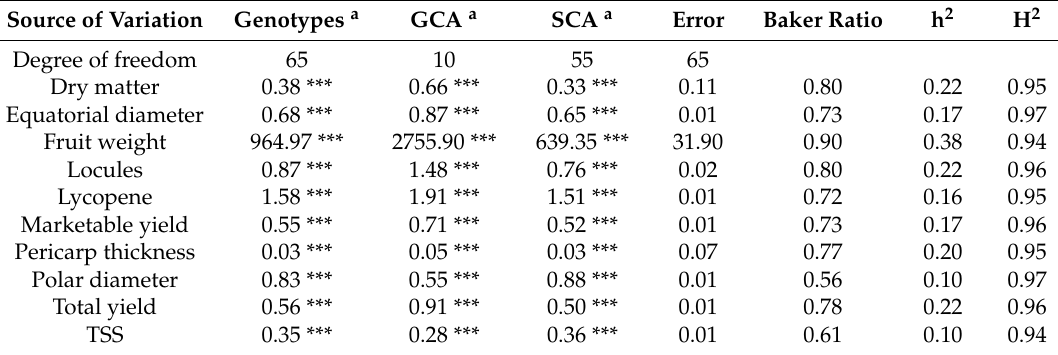
Table 2. Analysis of variance for general combining ability (GCA) and specific combining ability (SCA) for the ten descriptors in tomato under leaf curl virus conditions including the Baker ratio, narrow sense (h 2 ) and broad sense heritabilities (H 2 ).